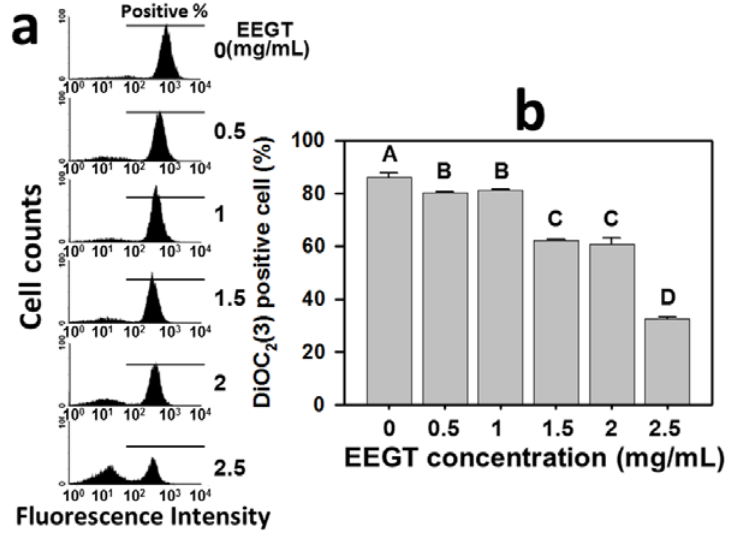
Figure 6. Ethanolic extracts of G. tenuistipitata (EEGT) reduced mitochondrial membrane potential (MMP) in Ca9-22 oral cancer cells. ( a ) Flow cytometry-based MMP profiles for EEGT-treated cells. Cells treated with different concentrations (0 to 2.5 mg/mL) of EEGT for 24 h. Positive % is indicated by horizontal lines; ( b ) Quantificative analysis of DiOC intensity. Data are presented as mean ± S.D. (n = 3). Differences between treatments of different concentrations containing the same capital letter at the top of each column are not